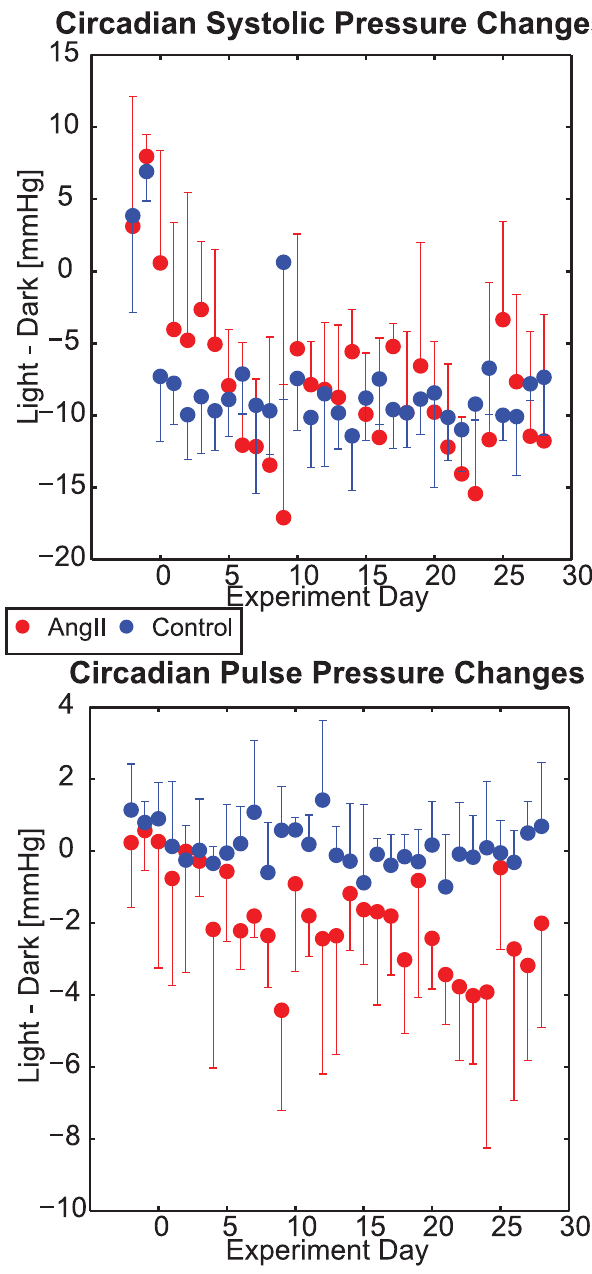
Fig 2. Circadian Changes in Blood Pressure Measurements by Group. Mean and standard deviations of individual subject differences in systolic (top) and pulse (bottom) blood pressure between the dark and light circadian cycles via implanted telemetry devices for mice as a function of the number of days they were continuously infused with ‘ AngII ’ (red) or saline ( ‘ Control ’ ; blue).